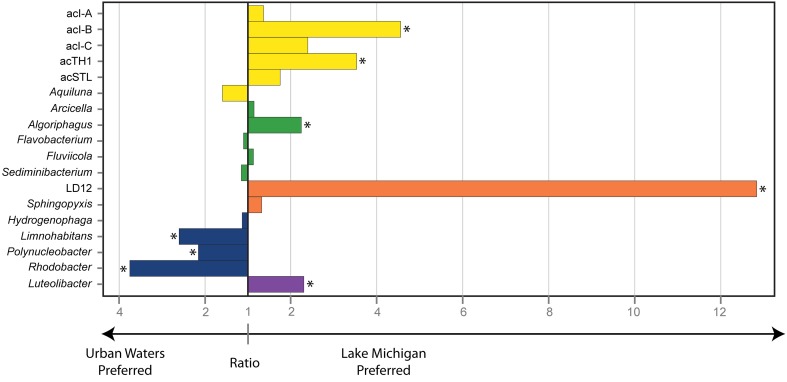
Magnitude of habitat preference between the Urban Estuary waters and Lake Michigan for common freshwater genera/lineages. Habitat preference is determined by the ratio of the mean relative abundance of each genus/lineage among the urban estuary samples vs. its mean relative abundance in the Lake Michigan samples. Bars plotting to the left indicate an urban estuary preference while bars plotting to the right indicate a Lake Michigan preference. A significant association (Mann-Whitney U-test, p ≤ 0.01) with either environment is indicated by an asterisk. Bar color indicates bacterial phylum where yellow, Actinobacteria; green, Bacteroidetes; orange, Alphaproteobacteria; blue, Betaproteobacteria; and purple, Verrucomicrobia.